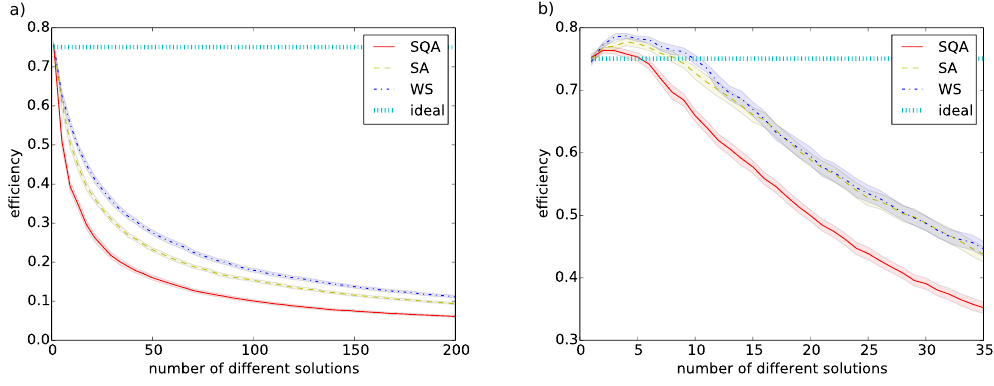
Figure 3: Average efficiency of a filter constructed from solutions found by each solver within 2000 runs. The average is taken over 20 randomly generated 4-SAT instances with n = 50 ≈ 8.06. a) The solutions used to construct the variables and a clauses-to-variables-ratio of α χ 4 filter are chosen randomly from the found solutions. b) The solutions used to construct the filter are chosen so that they maximize the average pairwise Hamming distance between the chosen solutions. The dotted cyan line shows the theoretical FPR for a filter constructed from truly independent